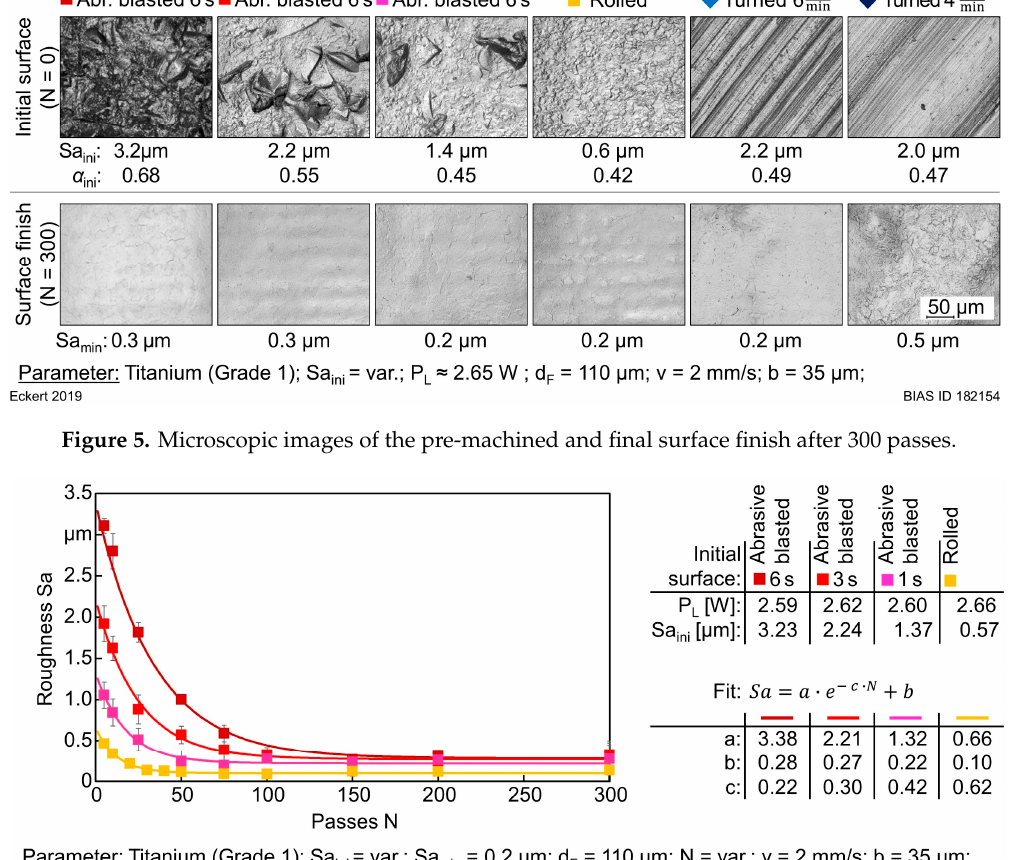
Figure 6. Roughness of the rolled and abrasive blasted surfaces after multiple passes and their exponential fit parameter.